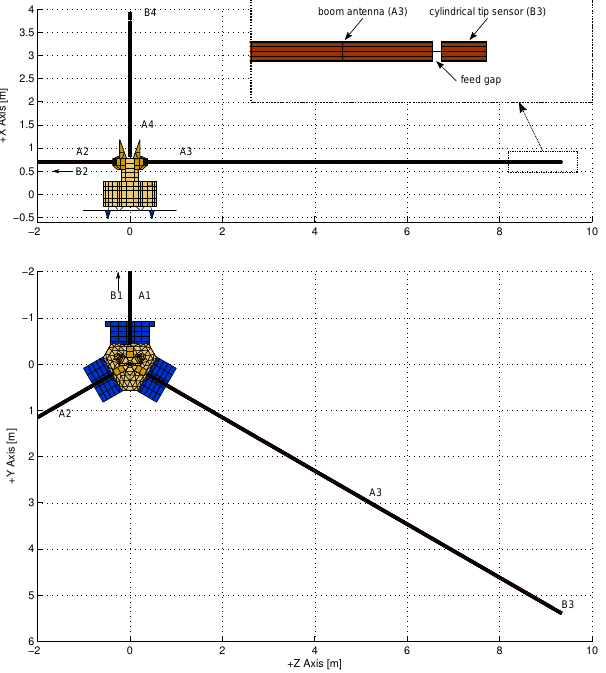
Figure 4. Final, detailed patch-grid model of the RESONANCE spacecraft, top and front